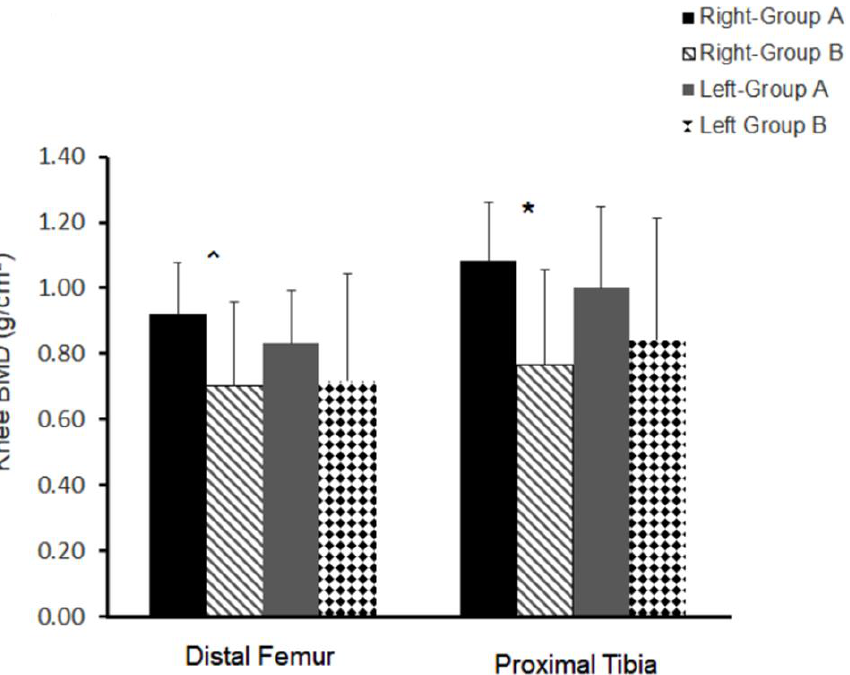
Figure 2. Distal femur and proximal tibia BMD with different musculoskeletal qualities in groups A and B classified based on NMES amplitude (greater or less than 100 mA) and leg extension repetitions (greater or less than 70 reps per week) in persons with chronic SCI. * denotes statistical significance between groups. ^ denotes trend between groups.